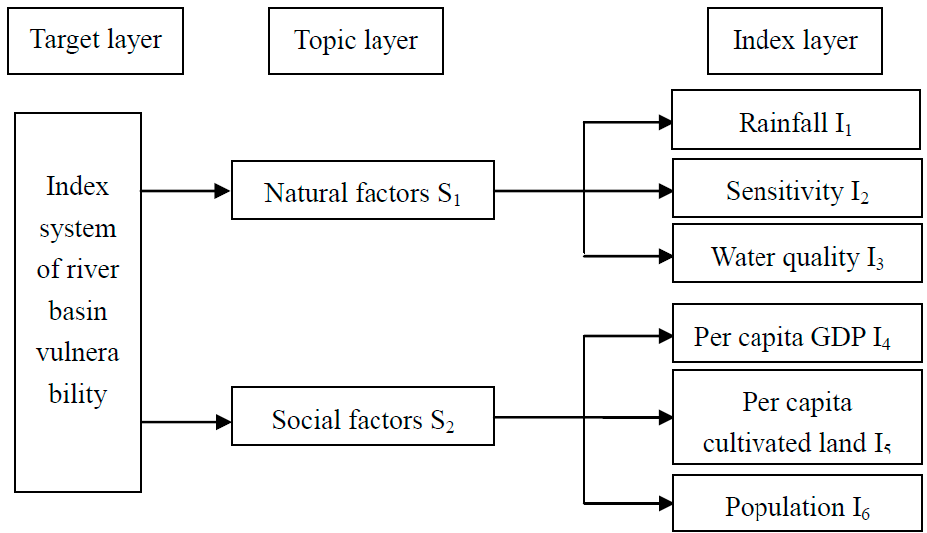
Figure 6. Index system of working unit vulnerability.